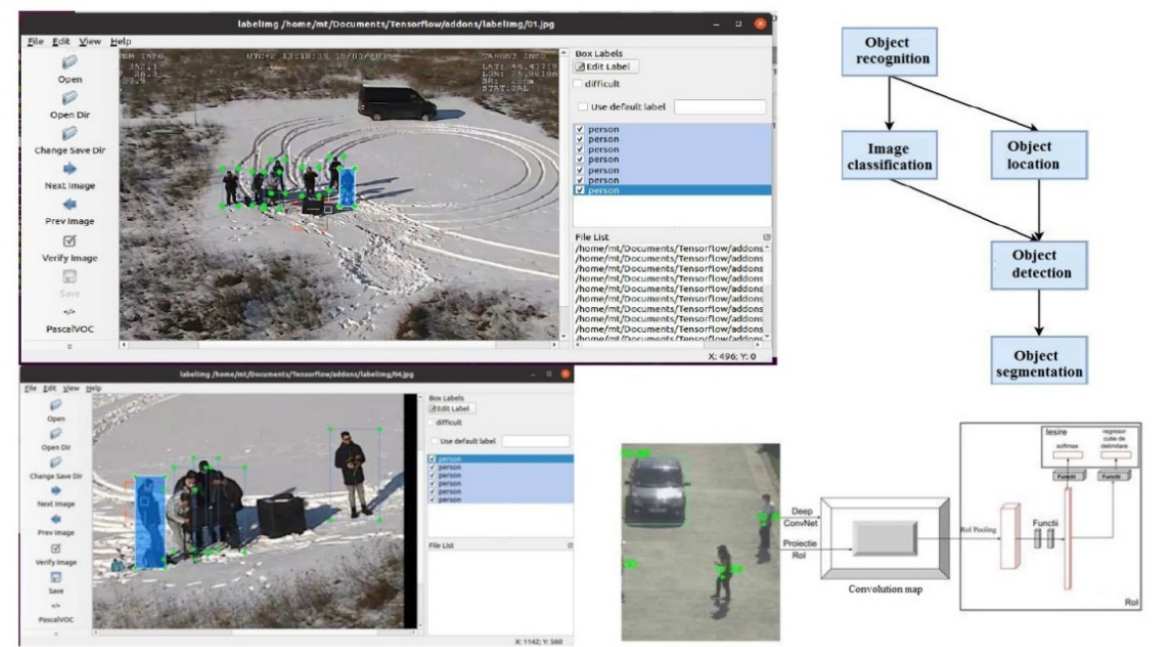
Figure 3. Chain of data acquisition in 19 Sol/UAV.